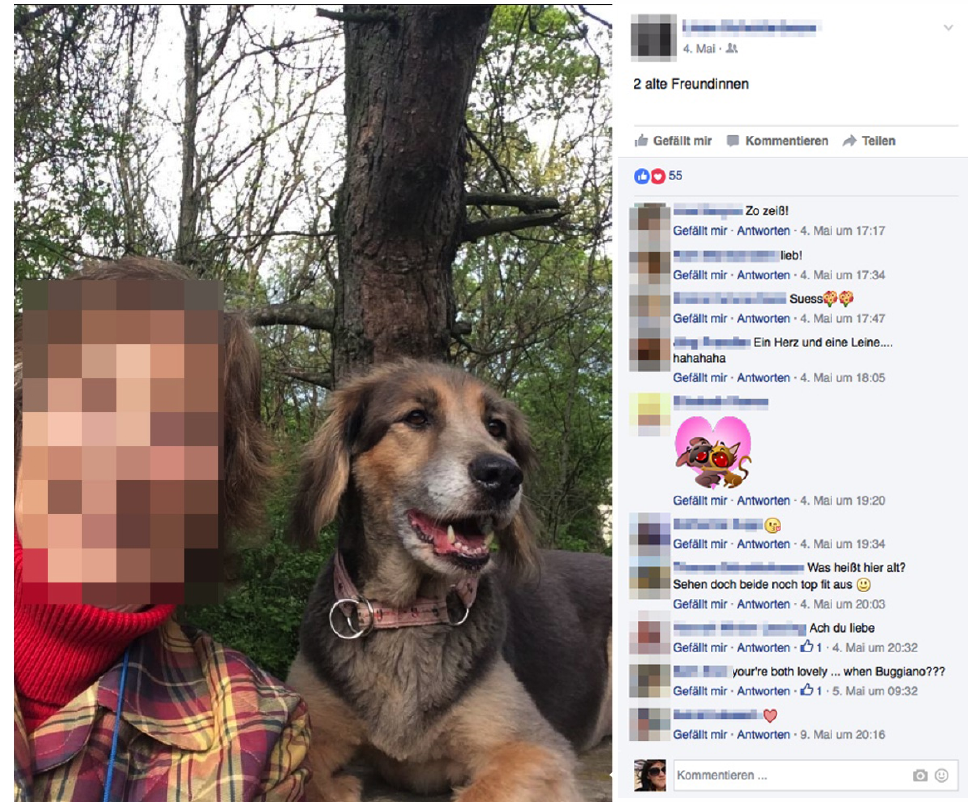
Figure 4. Screenshot of picture with caption and